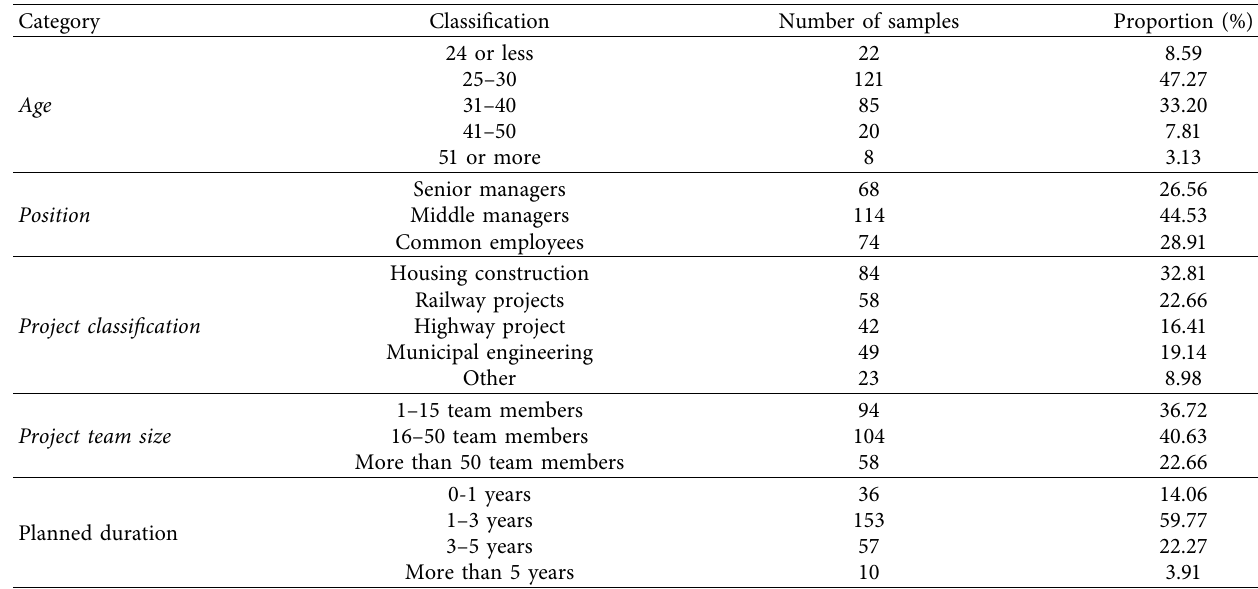
Figure 1: Research model. Table 1: Sample